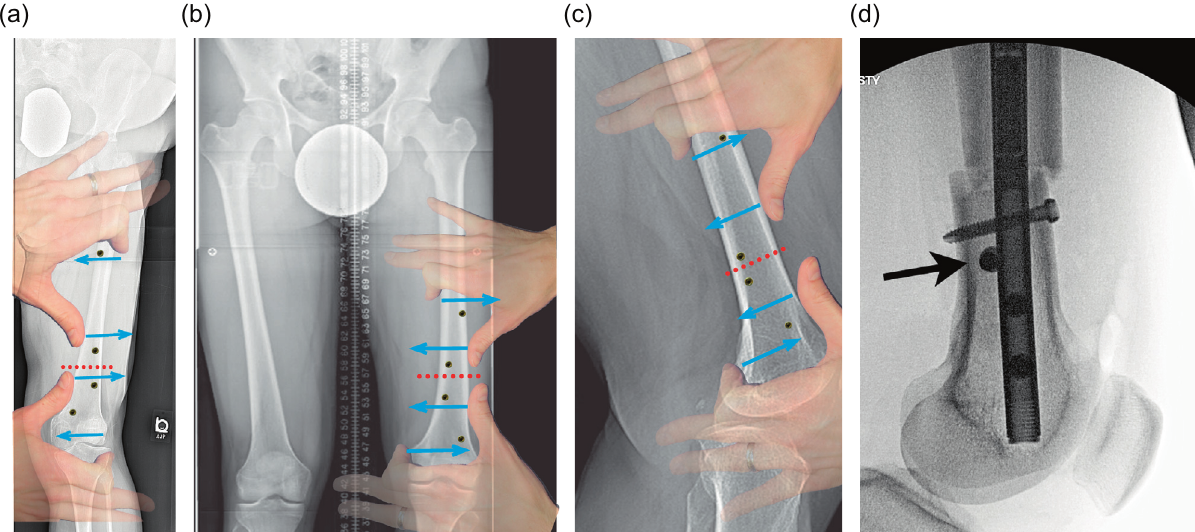
Figure 3. (a) This illustration shows the suggested position of the blocking screws for correction of a valgus deformity. The screws centered around the osteotomy are more typically used leaving the peripheral screws as an option. (b) The same planning can be used for correction of a varus deformity. The overlay of the hands is showing a principle called the ‘‘reverse rule of thumbs’’ whereby the bone is grabbed with the thumb and index fingers of both hands and a correction simulated. The blocking screws should be placed opposite the location of the thumb and index fingers. (c) In the sagittal plane, the blocking screws are inserted posterior to the ILN at the osteotomy site. The distal screw is the most important, but the proximal screw can also be used for a shorter nail. The peripheral screws are seldom needed. (d). This fluoroscopy shot shows ideal posterior blocking screw placement: close to the osteotomy site and lying against the ILN (arrow).